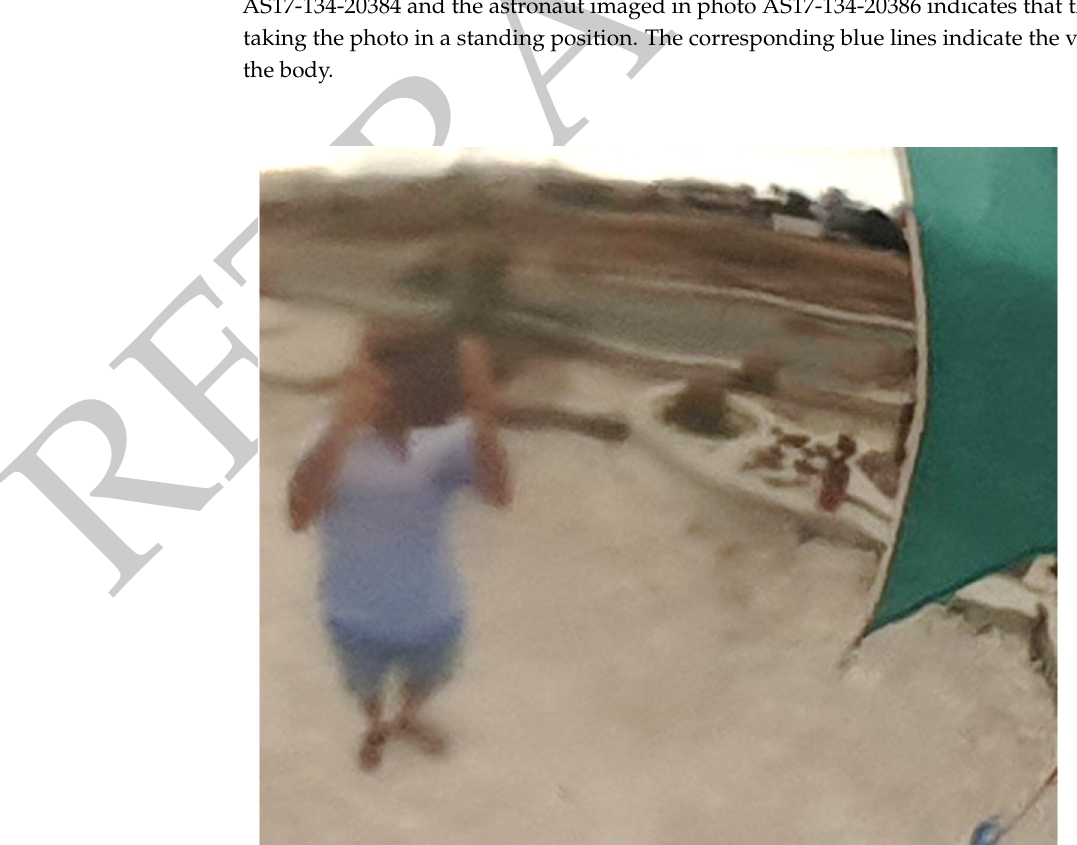
Figure 19. Reflection on a convex mirror. The top parts of the body are shown as more elongated than the lower ones, giving the impression that the photographer is viewed from above.